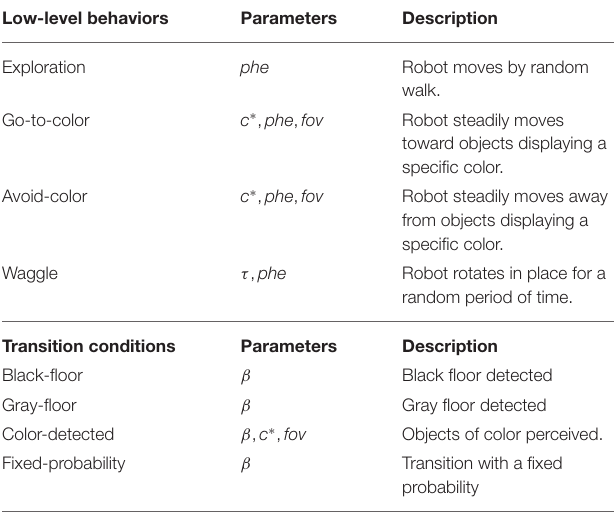
TABLE 2 | Low-level behaviors and transition conditions used in Phormica . Low-level